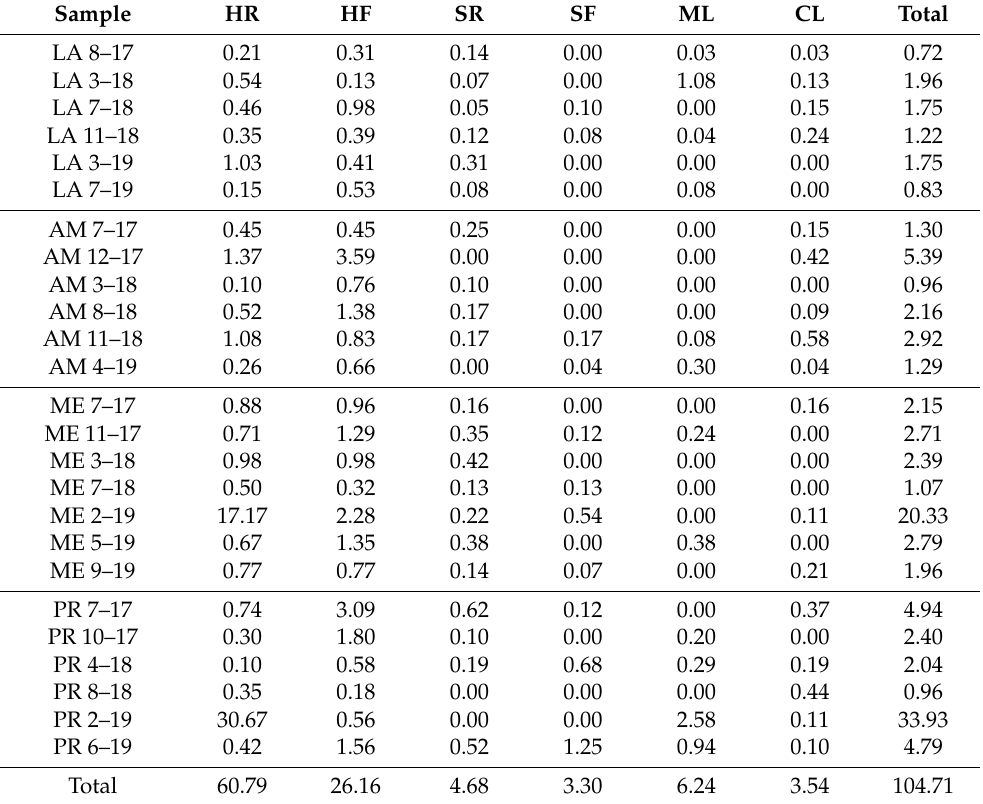
Table 1. Abundance (items/m 3 ) of the different morphotypes of microplastic fragments in each of the samples collected from the four areas (Latsi—LA, Amathounta—AM, Meneou—ME and Pro-taras—PR). The six morphotypes of fragments are HR = ‘hard rounded’, SR = ‘soft rounded’, HF = ‘hard flattened’, SF = ‘soft flattened’, ML = ‘membrane like’, CL = ‘cable like’. Description of these morphotypes is provided within the text. (The two first letters in the code name of each sample refers to the area of sampling, followed by the sampling month and the sampling